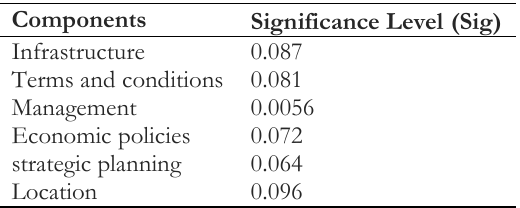
Table 3. Kolmogorov -Smirnov test